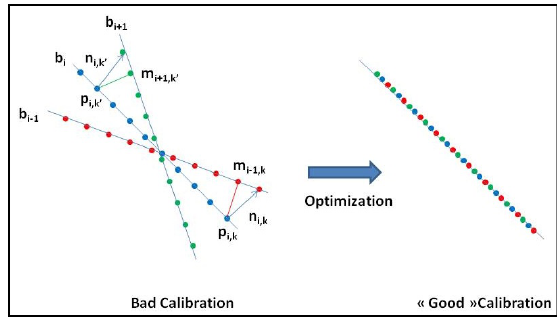
Figure 3: Side-view of a planar